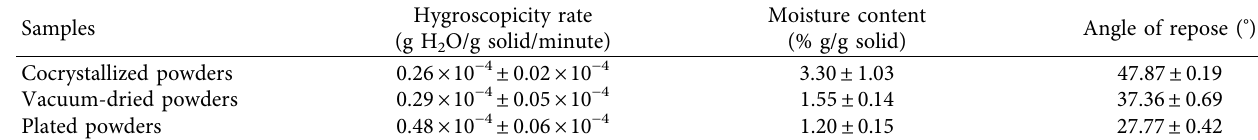
Table 4: Physicochemical properties of moringa leaves extract